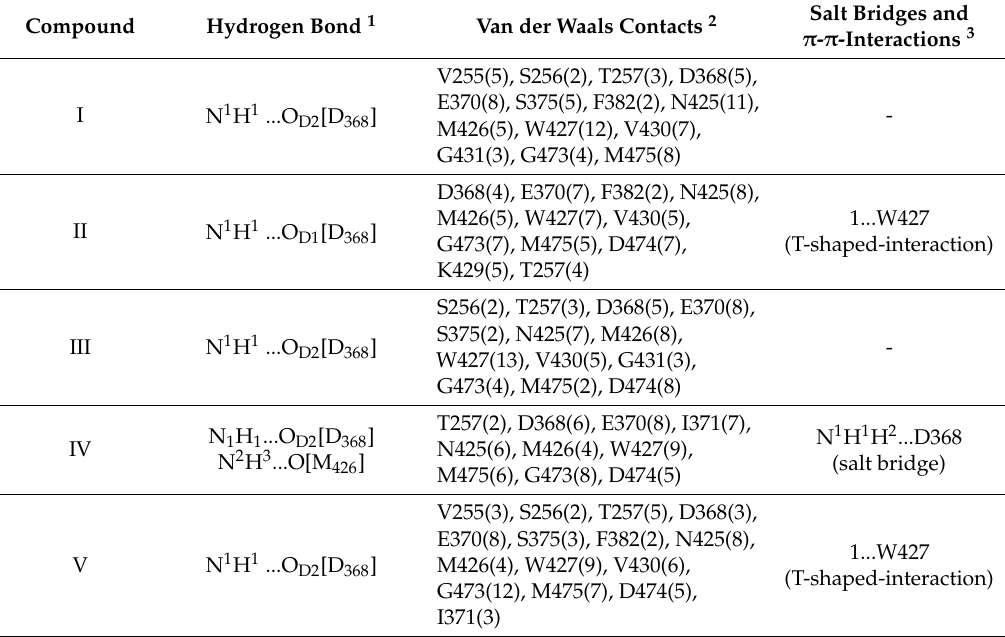
Table 2. Intermolecular interactions in the optimized models of the CD4-mimetic candidates bound to the gp120